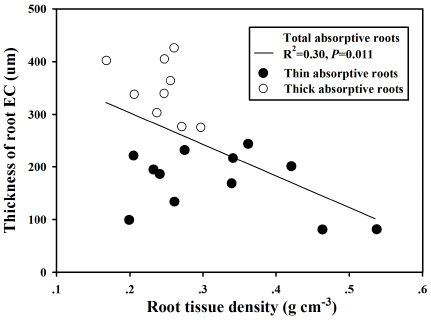
Figure 4. Relationships between root tissue density and thickness of root EC for total, thin (solid circles, black line), and thick (open circles) absorptive